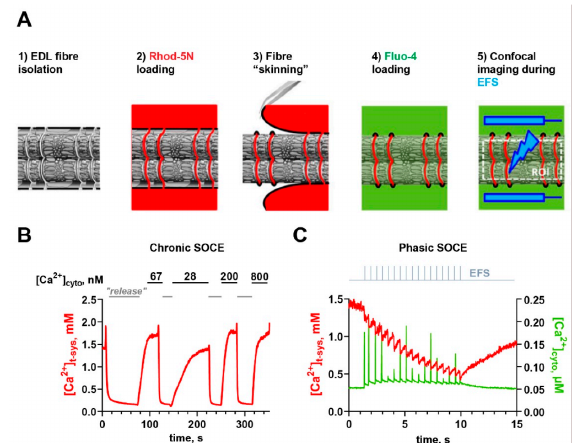
Figure 3. Two fluorescence-based techniques to measure SOCE in skinned skeletal muscle fibers. ( A ) Schematic representation of the different protocol steps to perform measurements of either chronic SOCE (steps 1–3) or phasic SOCE (steps 1–5). (1) Isolation of an EDL muscle and preparation of